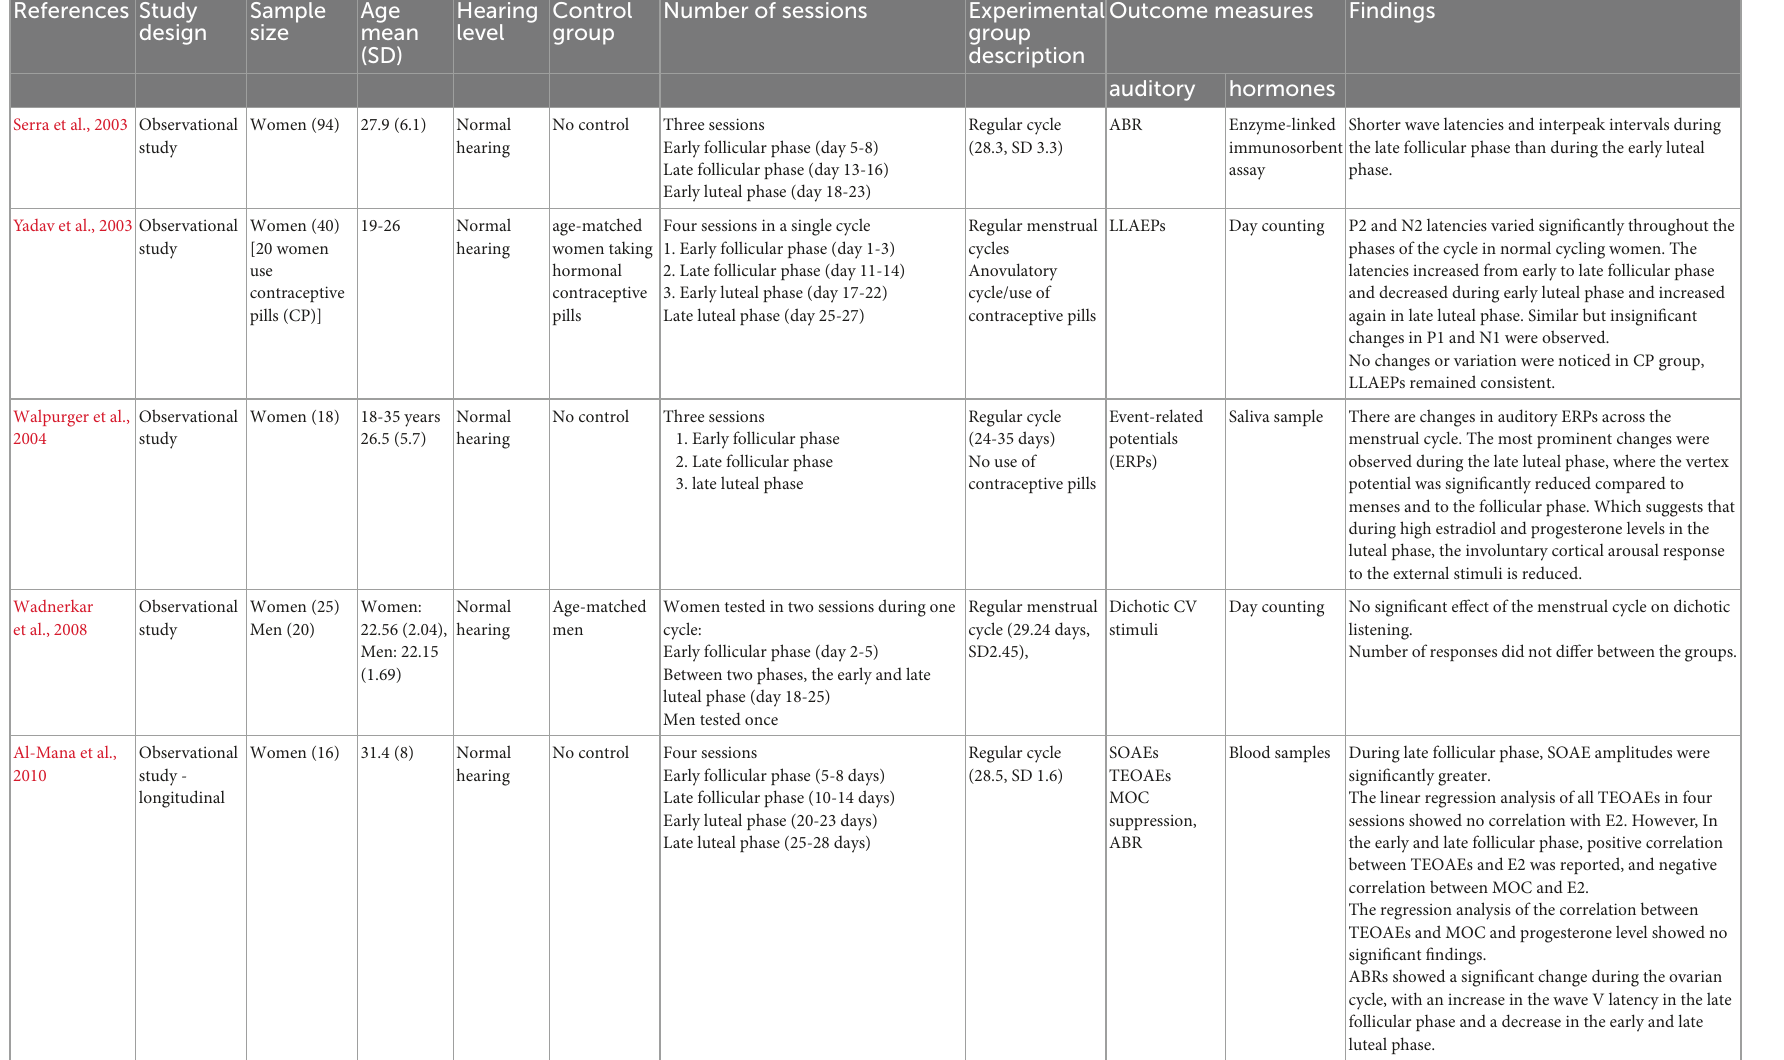
TABLE 2 Summary of the characteristics and results of studies on “the fluctuation of auditory function during the menstrual